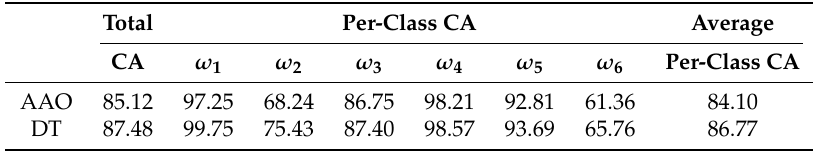
Figure 6. Result of ICESAR ice type classification from numerically optimized DT. Table 4. Classification Accuracy (%) for ICESAR dataset for all-at-once (AAO) and decision-tree (DT)